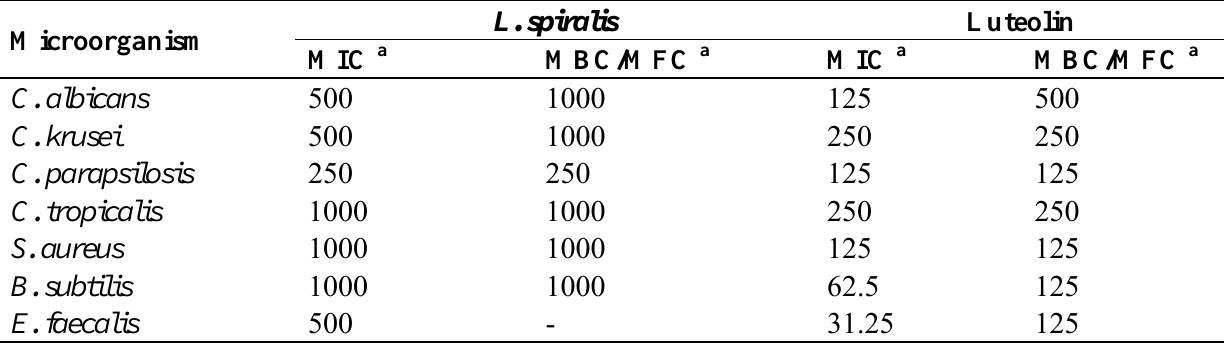
Table 2. Antibacterial and antifungal activity of the methanolic extract of L. spiralis leaves and luteolin. Minimal inhibitory concentration ( MIC); minimal bactericidal concentration (MBC); minimal fungicidal concentration